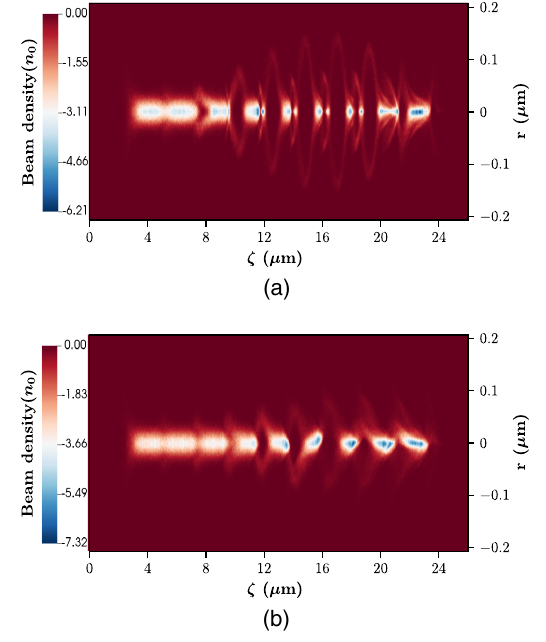
FIG. 9. Observed beam destruction due to phase shifting of the plasma wake at B ¼ 0 . 04 (a) and hosing instability at B ¼ 0 . 02